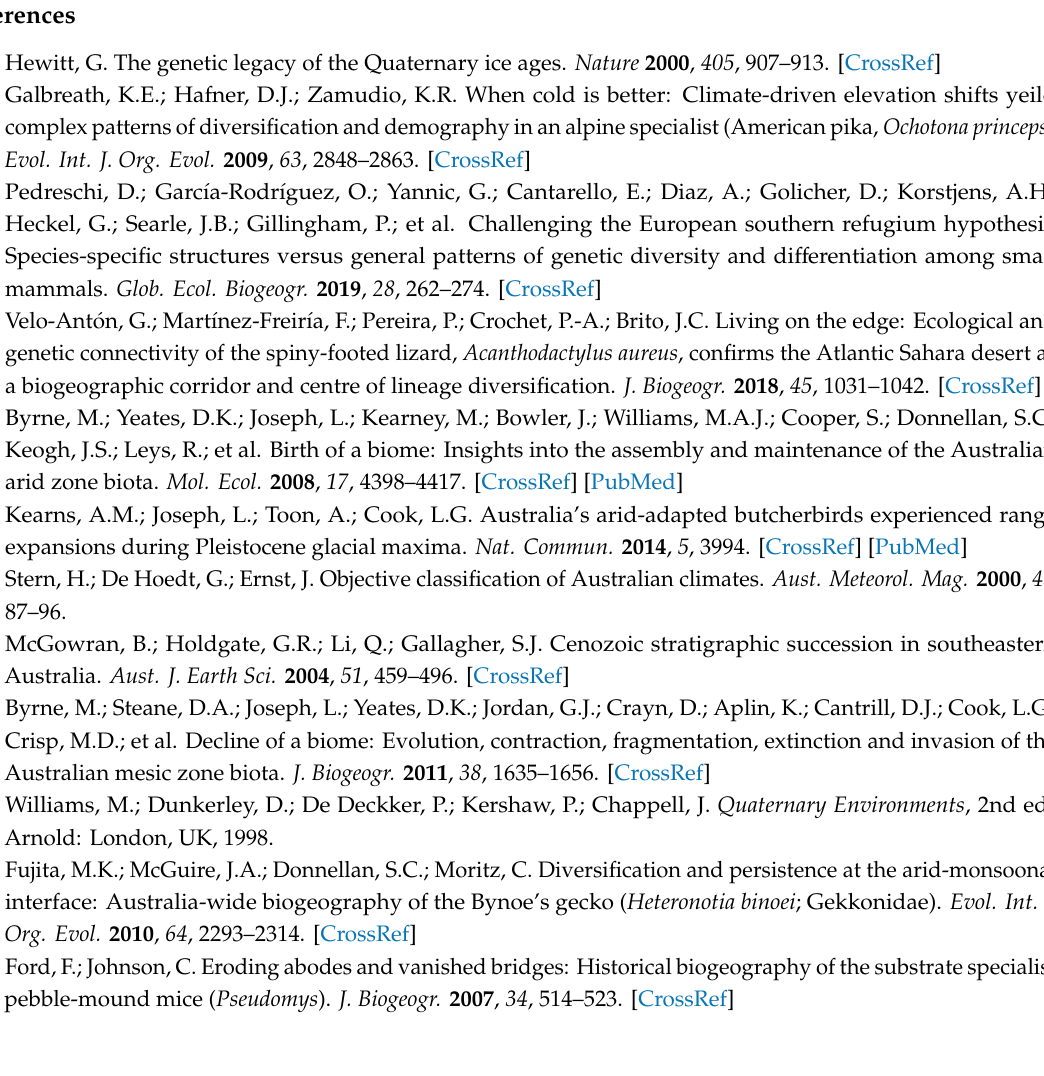
Figure S1: Nuclear DNA networks, Figure S2: Concatenated mtDNA networks and maps showing the geographic distribution of major haplo groups, Table S1: Genbank Accession numbers and specimen voucher information for samples sequenced, Table S2: Primers used for PCR amplification and